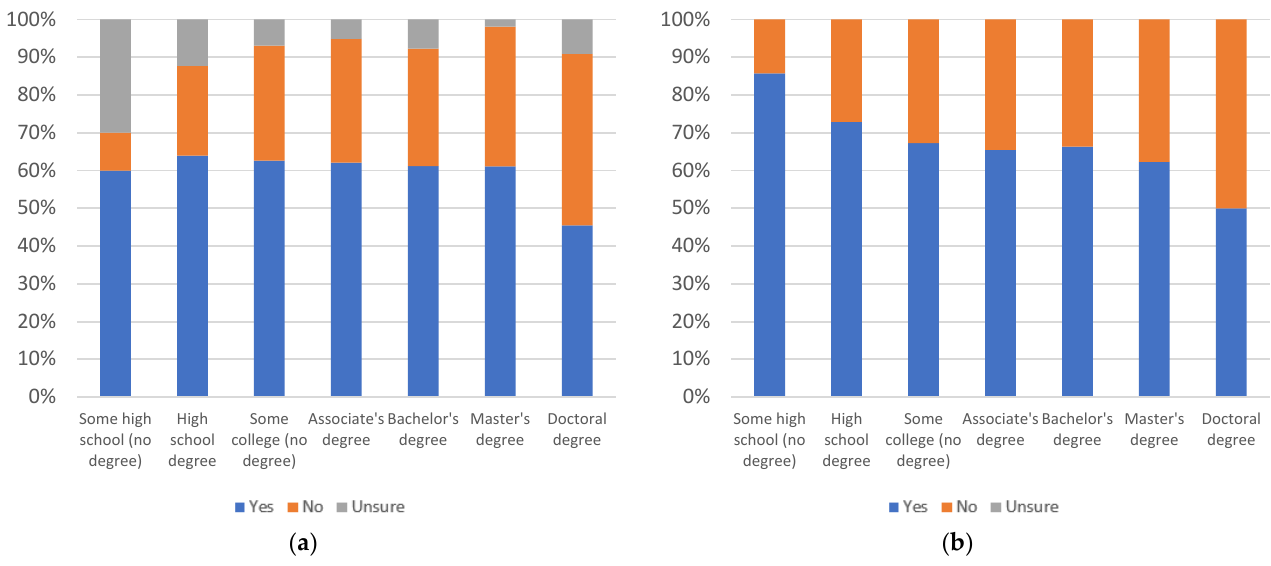
Figure 86. Label helpfulness, by education level: ( a ) with uncertain respondents (left) and ( b ) without uncertain respondents (right).